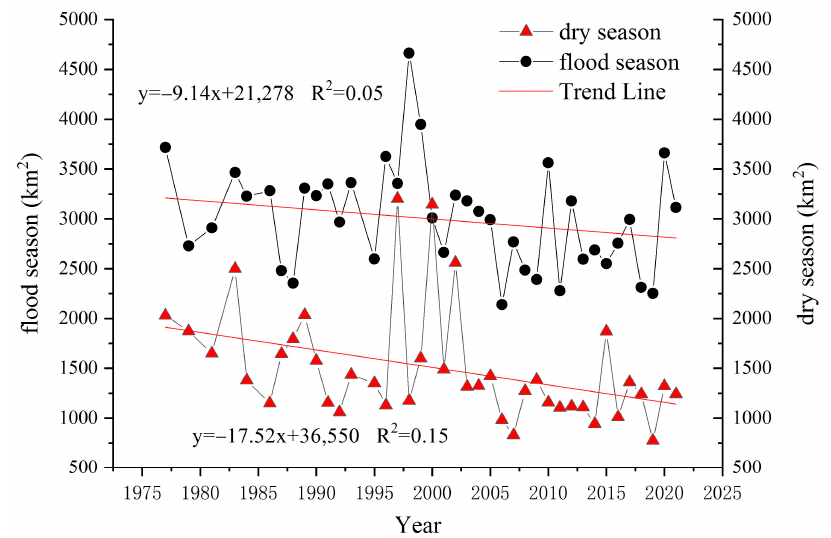
Figure 3. Characteristics of water area variation in the Poyang Lake during 1977–2021.